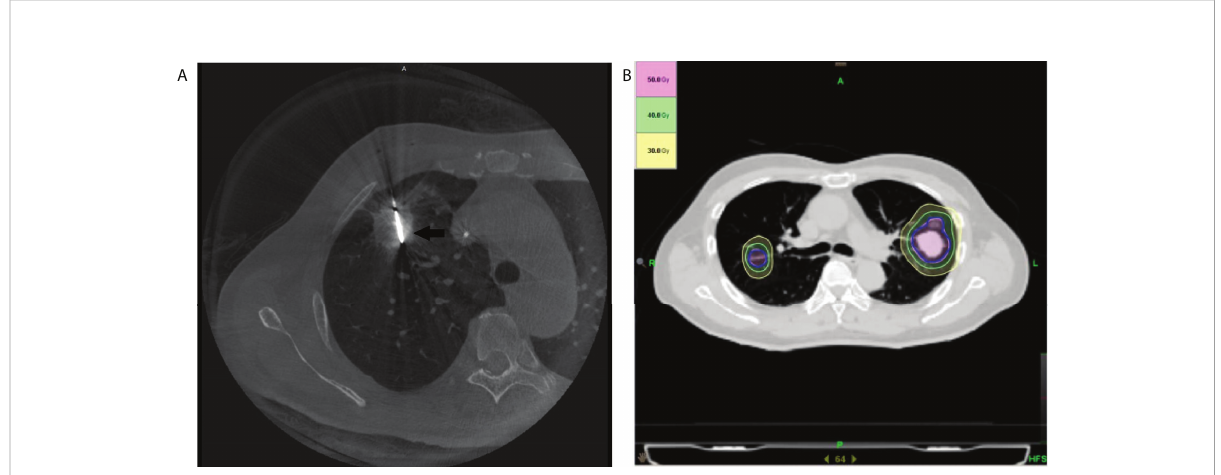
FIGURE 1 Illustration of the treatment plan. (A) The axial cone beam CT image obtained during microwave ablation shows a microwave antenna positioned in the tumor (arrow). (B) An SBRT treatment plan with isodose curve distribution for a patient with bilateral pulmonary metastasis of hepatocellular carcinoma is